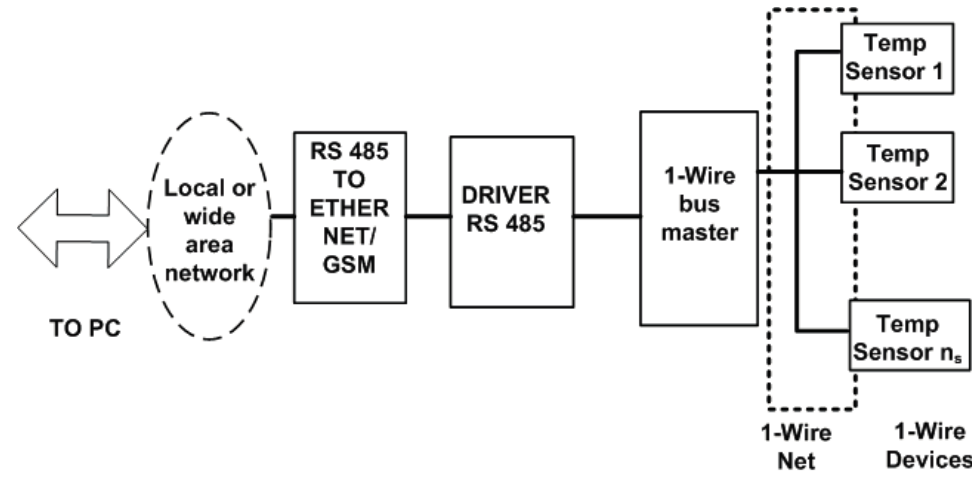
Figure 4. Block-level diagram of the designed instrumentation